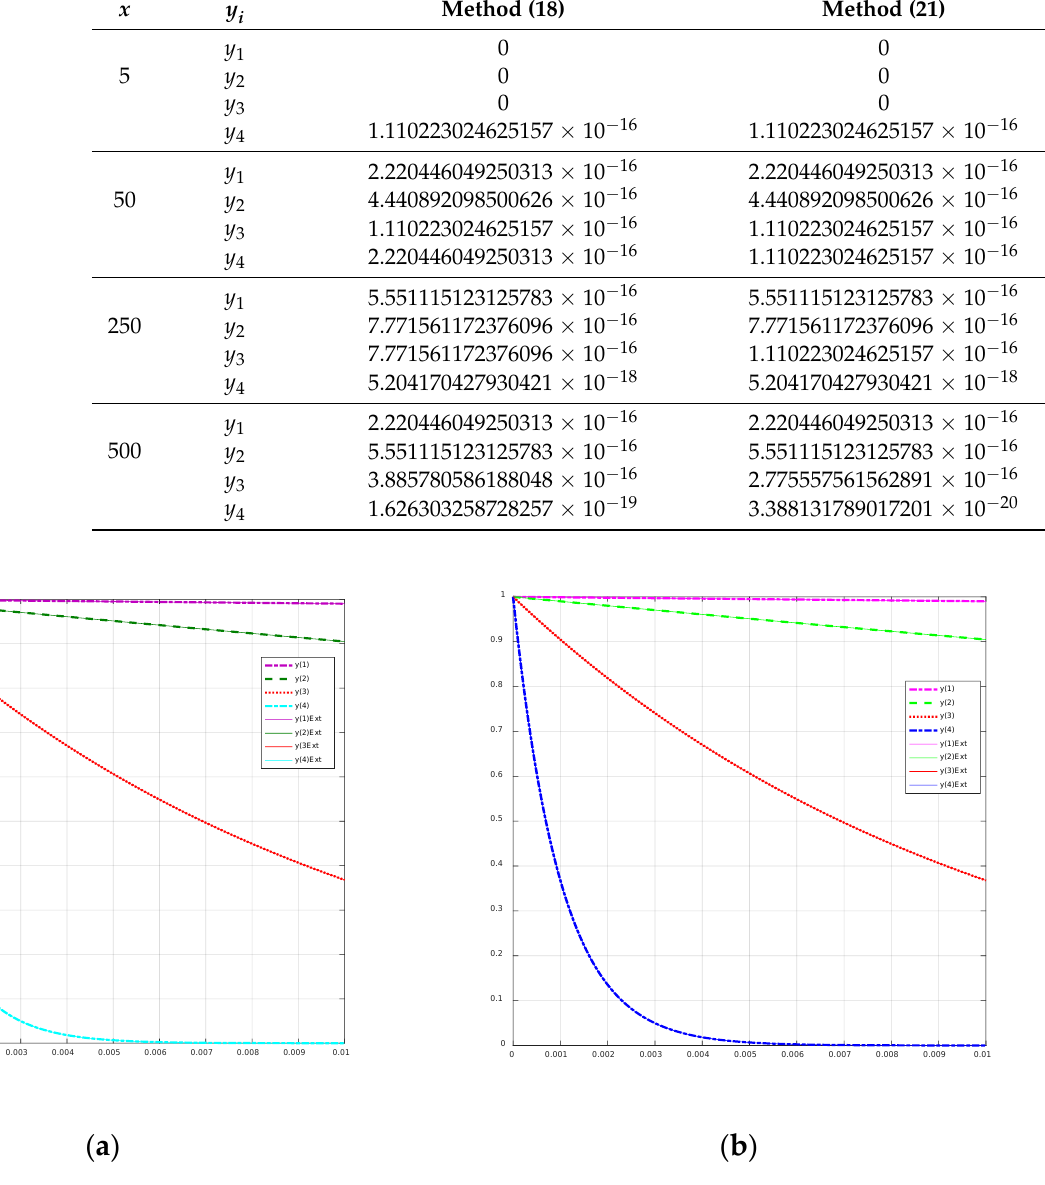
Figure 5. Graphical plots of Example 3 using block hybrid methods with nfe = 500. ( a ) Solution curve of Example 3 using (18); ( b ) solution curve of Example 3 using (21).